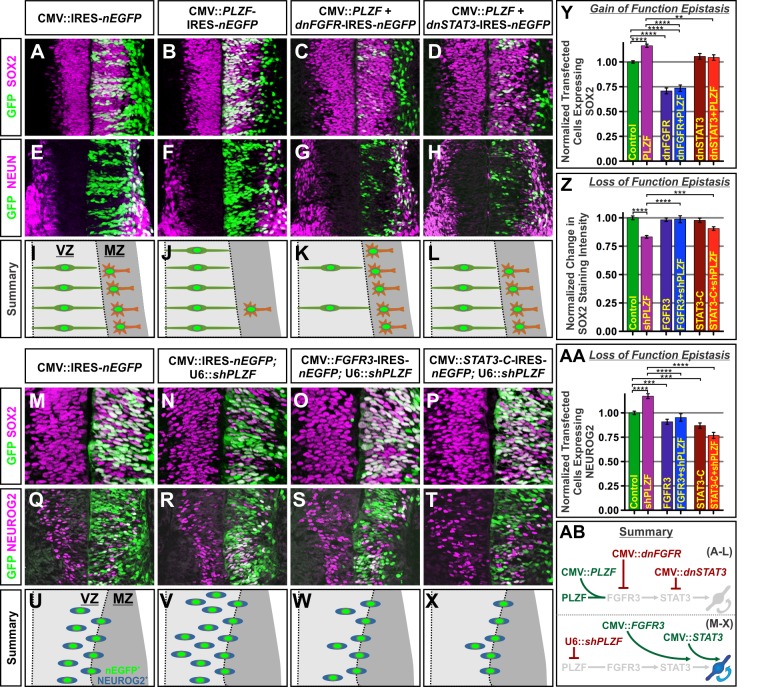
FGFR3 and STAT3 expression and activity are epistatic to PLZF.(A–L) The ability of ectopic PLZF to hold cells in a SOX2+ progenitor state and suppress neurogenesis is blocked by the coexpression of either dnFGFR or dnSTAT3. These electroporations were performed at e3 (HH 17) and analyzed at e5 (HH 25). (M–X) The reduced intensity of SOX2 expression and increased numbers of cells expressing NEUROG2 following PLZF knockdown are restored by coexpression with either FGFR3 or STAT3-C. These electroporations were performed at e2 (HH 10) and analyzed at e4 (HH 21). (Y, AA) Charts display the mean number of cells expressing SOX2 or NEUROG2 ± SEM between the indicated experimental conditions relative to empty vector controls. (Z) Chart displays the mean pixel intensity of SOX2 staining ± SEM relative to empty vector controls. Counts were based on at least 12 images taken from ≥8 electroporated embryos. *p<0.05, ***p<0.001, and ****p<0.0001. (AB) Summary of the epistasis tests used to show that FGFR3 acts downstream of PLZF.